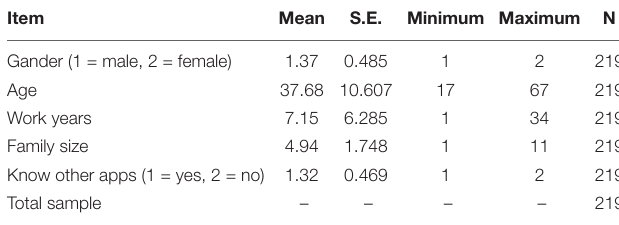
TABLE 1 | Descriptive statistics of respondents’